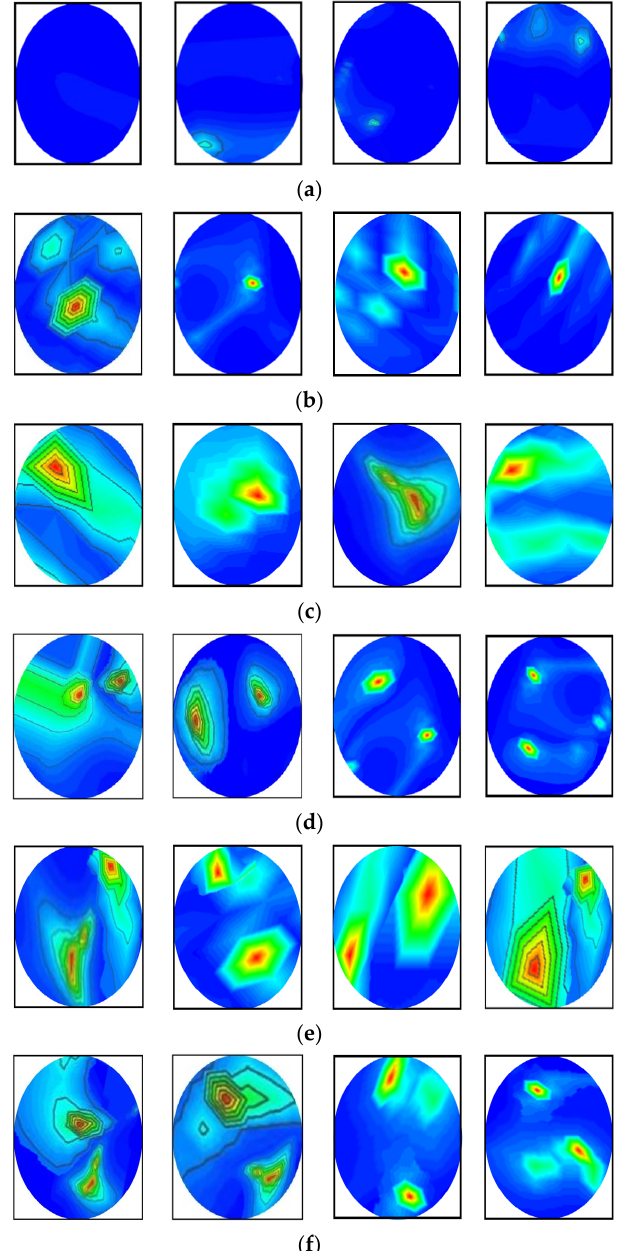
Figure 5. Randomly selected RMB image samples from the original dataset: ( a ) NT class, ( b ) Single BT class, ( c ) Single MT class, ( d ) BBT class, ( e ) MMT class, ( f ) BMT class.